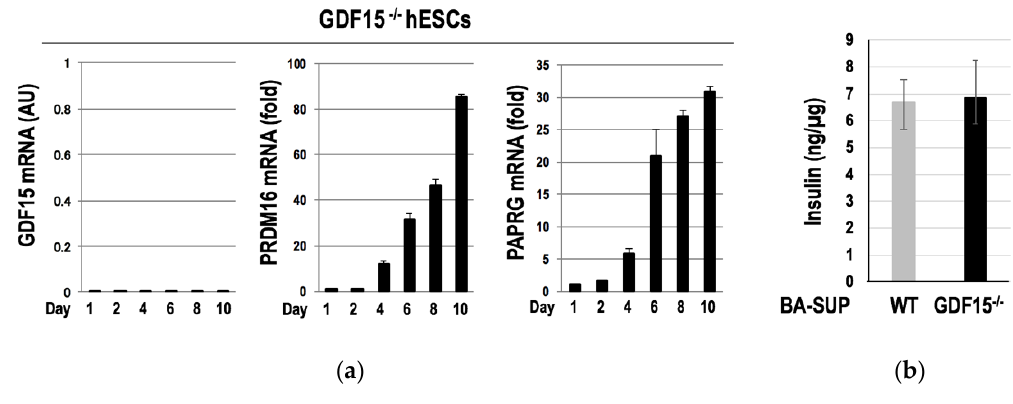
Figure 4. GDF15 - /- hESCs normally differentiated into BAs. GDF15 -/ - hESCs were subjected to differentiation into BAs. The expressions of the two major BA-selective genes, PRDM16 and PPARG , were properly induced in GDF15 -/- hESCs despite the lack of GDF15 expression ( n = 3 experiments) ( a ). There were no differences in the activities of the BA-SUP to enhance insulin secretion from murine pancreatic beta cells between WT and GDF15 -/- hESCs ( n = 3 experiments) ( b ). Data are shown as mean ± SD.